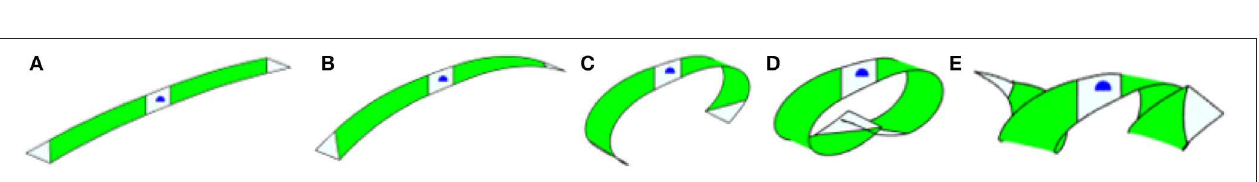
FIGURE 14 | Twisting of 50 × 5rectangular plate. (A) Electric field 25 MV/m; (B) electric field 43 MV/m; (C) electric field 68 MV/m; (D) electric field 86 MV/m; and (E) electric field 105